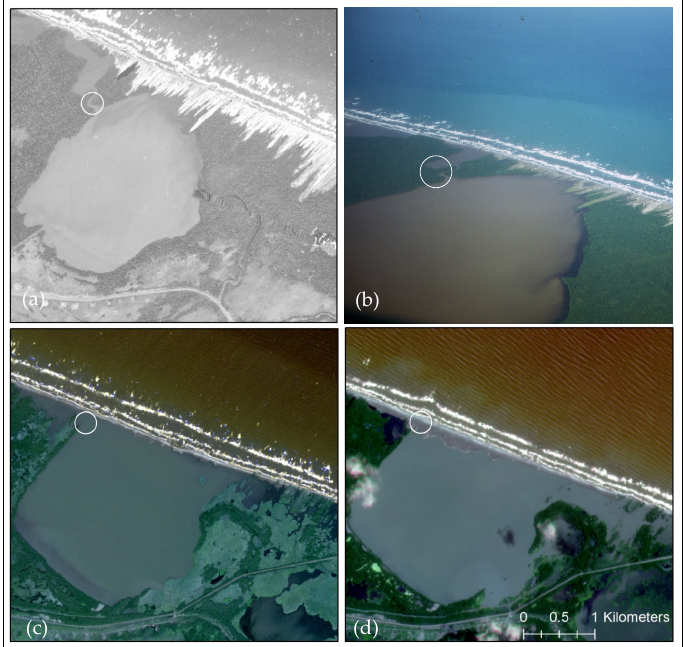
Figure 2. Evolution of Cuatro Bocas lagoon as shown in ( a ) aerial photograph from 1954, ( b ) oblique aerial photograph from 1971, ( c ) Geoeye satellite image taken in 2011, and ( d ) Geoeye sat- ellite image taken in 2020. The circle indicates the same location on each image. Geoeye imagery courtesy of Planet Labs.